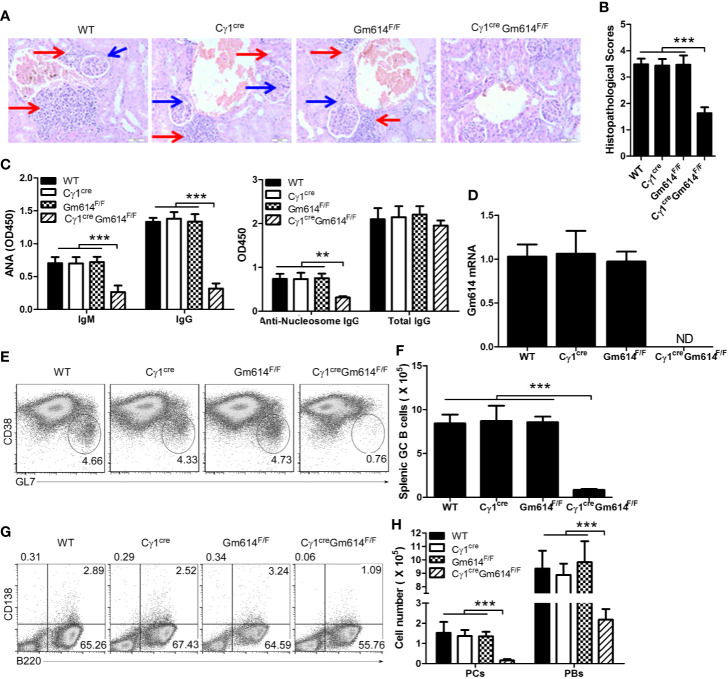
Gm614 knocked-out (KO) in GC B cells (Gm614 cKO) mitigated symptoms in pristane-induced lupus. Nine-week-old WT, Cγ1cre (Cγ1-cre), Gm614F/F (Gm614fl/fl), and Cγ1creGm614F/F (Gm614 cKO) mice were i.p. injected with 0.5 ml pristane and analyzed after 6 months. (A) Gm614 cKO reduced infiltrated inflammatory cells in the kidney of pristane-induced lupus. H&E-stained sections of the kidney. Scale bars, 50 µM. Blue arrows show glomeruli; red arrows show infiltrated inflammatory cells that appeared in the surrounding interstitial vasculature. (B) Gm614 cKO reduced histopathological scores of kidney. Histopathological scores were assessed based on loss of brush border, grading of tubular necrosis, tubular dilatation, and cast formation in 10 randomly chosen, non-overlapping fields. (C) Gm614 cKO reduced autoantibodies in pristane-induced lupus. Anti-nucleic antibodies (ANA) IgM and IgG, anti-nucleosome IgG, and total IgG were determined in the sera using ELISA assay. (D) Gm614 was depleted in Gm614 cKO mice. Splenic CD19+B220+CD38loGL7hi GC B cells were sorted by FACS and subject to qPCR. (E, F) Gm614 cKO reduced GC B cells in pristane-induced lupus. On gated of CD19+B220+ B cells, CD38loGL7hi GC B cells were analyzed by FACS. The percentages (E) and absolute numbers (F) of splenic GC B cells are shown. (G, H) Gm614 cKO reduced PBs and PCs in pristane-induced lupus. The percentages (G) and absolute numbers (H) of splenic CD138+B220+ PBs and CD138-B220+ PCs cells are shown. (A–H) Data represent three independent experiments, with six samples per group per experiment. (B, D, F) One-Way and (C, H) Two-Way ANOVA was followed by Bonferroni post-tests, Error bars, s.e.m., ***p < 0.001.